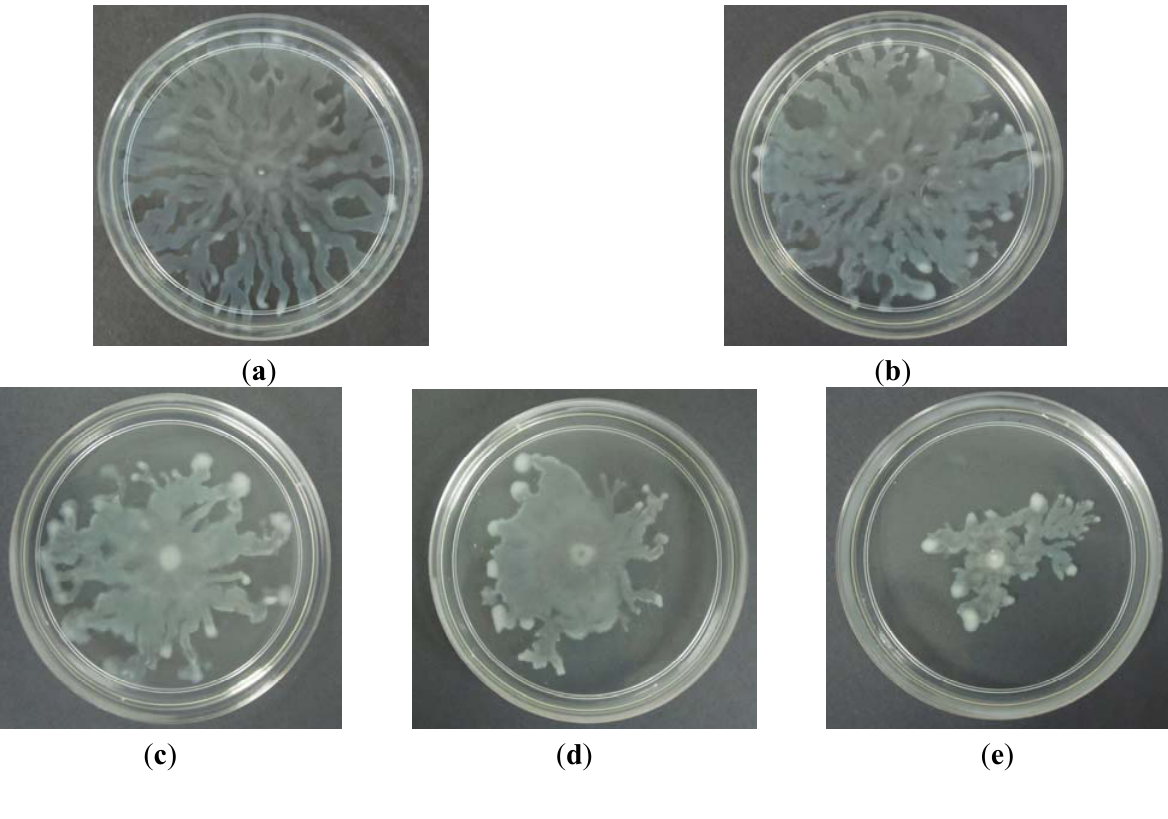
Figure 6. Swarming inhibition assays. Swarming agars of P. aeruginosa PA01 ( a ); supplemented with ultrapure water ( b ); (v/v, negative control); and caffeine of 0.1